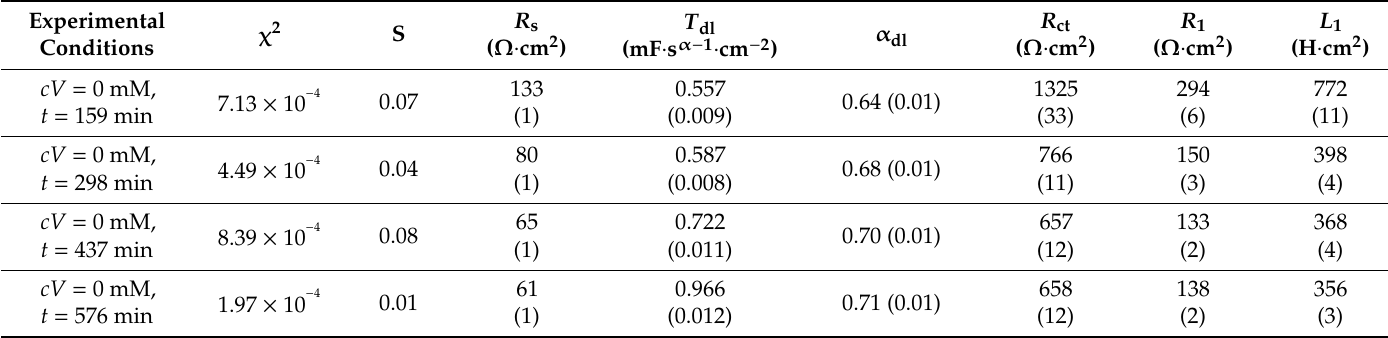
Table 5. The results of fitting of the impedance spectra obtained at pH = 2.5 using EEC from Figure 11a: χ 2 and S indicate the quality of the fit (chi-square and residual sum of squares, respectively); R s is the solution resistance; T dl is the constant phase element CPE dl parameter representing the electrical double layer; α dl is the exponent of the CPE; R ct is the charge-transfer resistance; L 1 and R 1 are the inductance and resistance related to the adsorption processes, respectively, uncertainties of the fitted parameters are given in